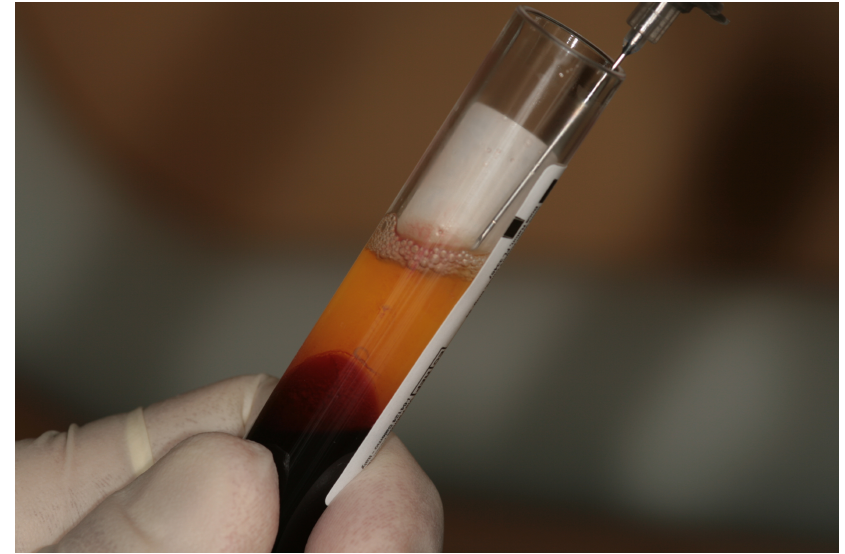
Figure 1. Liquid fibrinogen collection from white-cap tube.